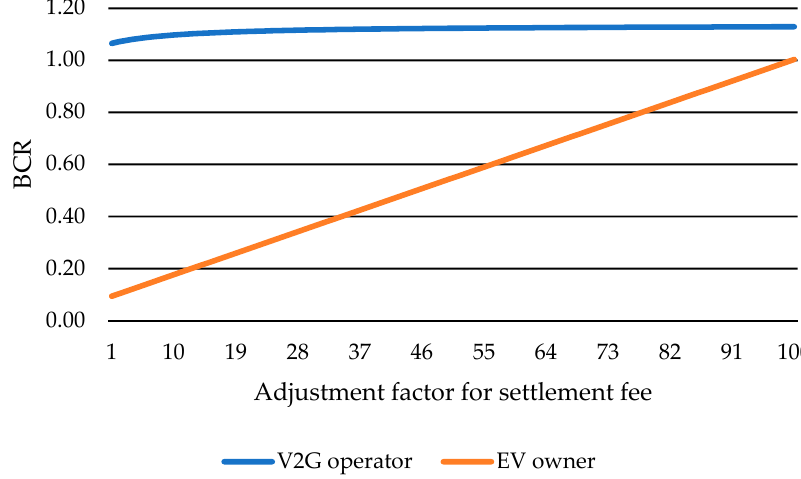
Figure 9. V2G-service operator and EV owner BCRs with DC chargers.